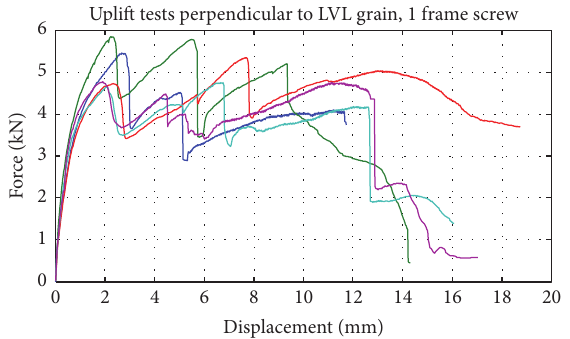
Figure 7: Load-displacement curves for uplift tests perpendicular to LVL grain with a single screw